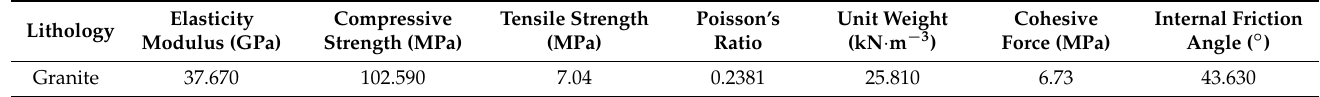
Table 1. The mechanical parameters of the material.